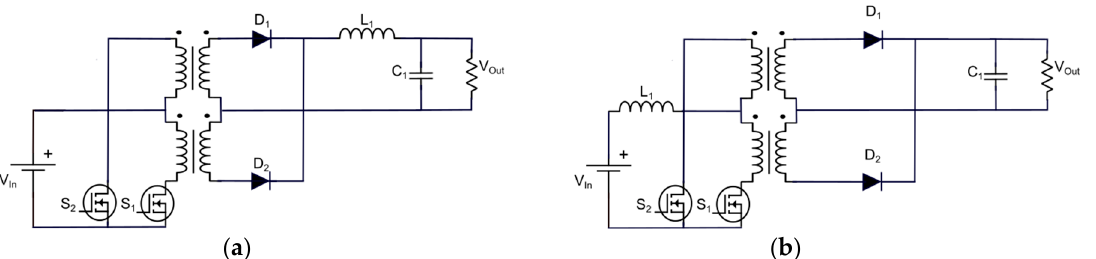
Figure 5. Buck-boost push-pull converter ( a ). Current-fed push-pull DC-DC Converter ( b ).